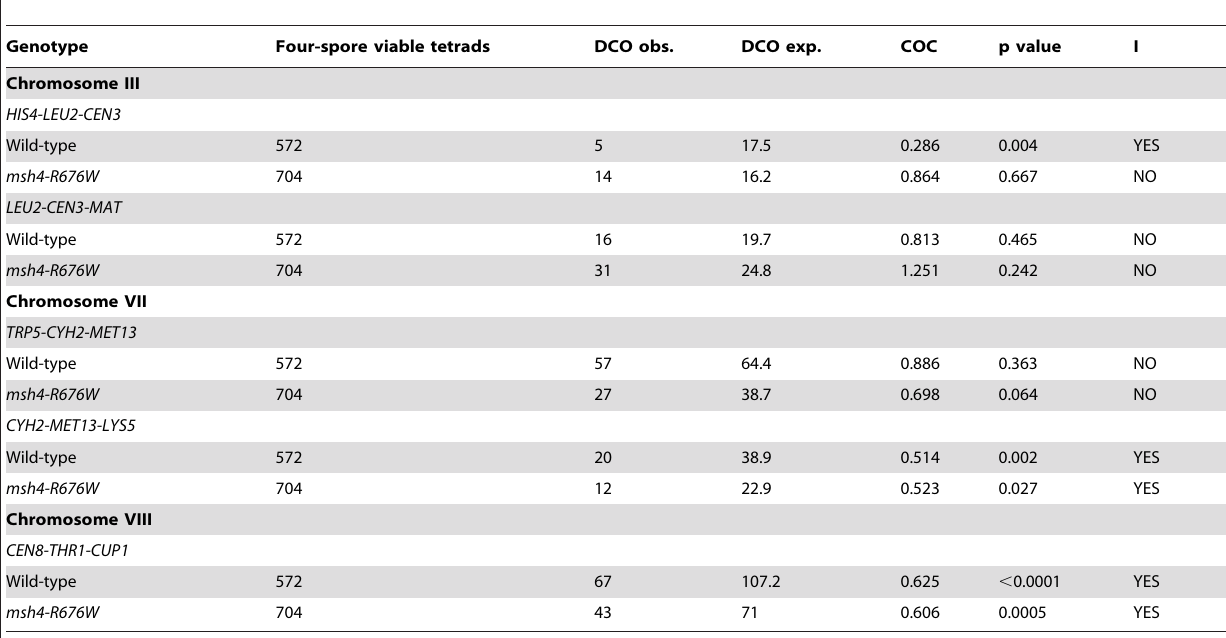
Table 4. Analysis of crossover interference in msh4-R676W by coefficient of co-incidence.